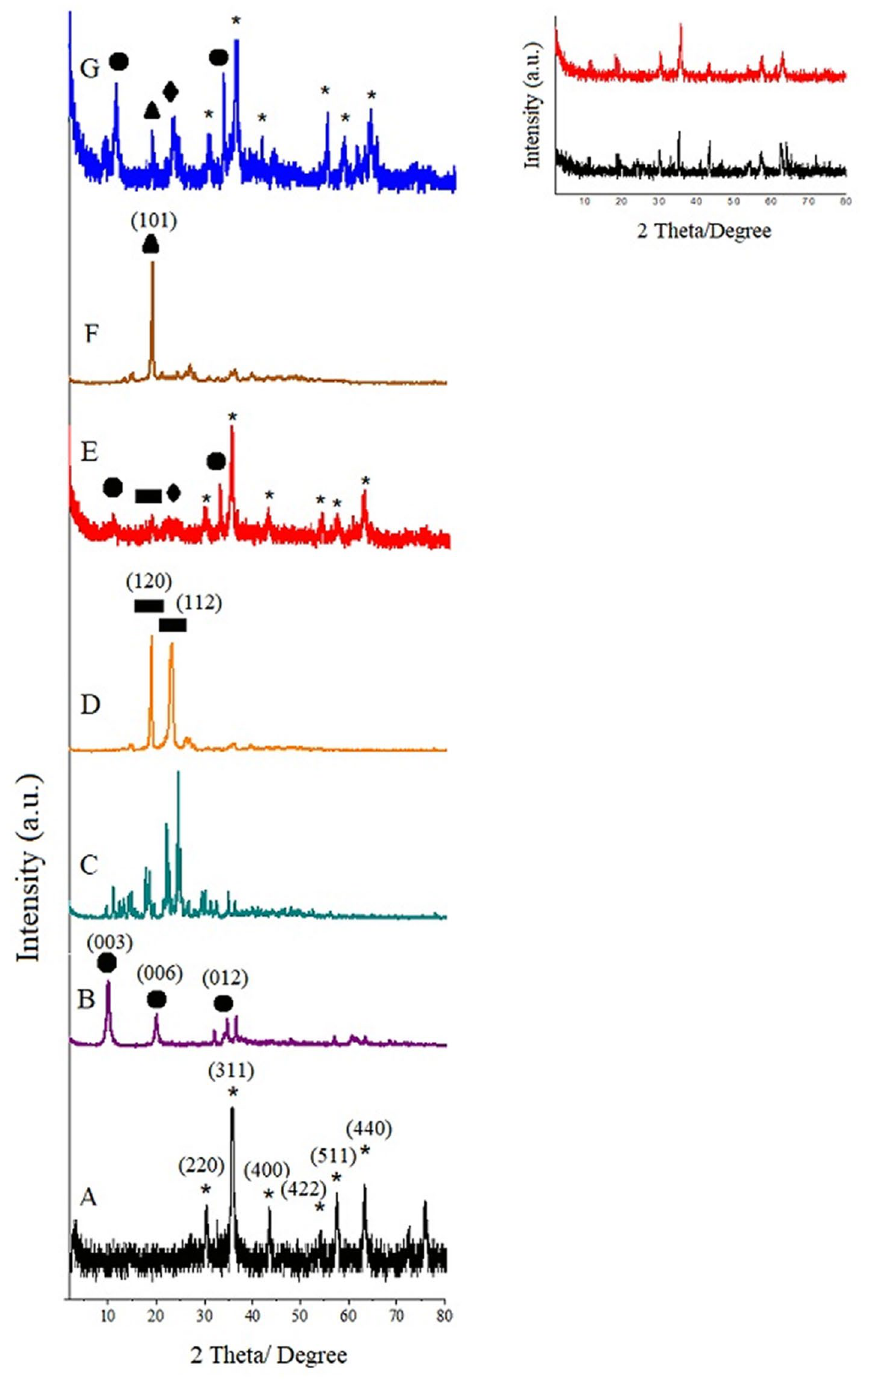
Figure 2. X-ray diffraction patterns for ( A ) iron oxide nanoparticles; ( B ) MLDH; ( C ) pure sorafenib; ( D ) pure PEG; ( E ) core–shell nanoparticles (FPEGSO-MLDH); ( F ) pure PVA; ( G ) core–shell nanoparticles (FPVASO- MLDH). Inset shows the XRD patterns of ( H ) FPEGSO and ( I )